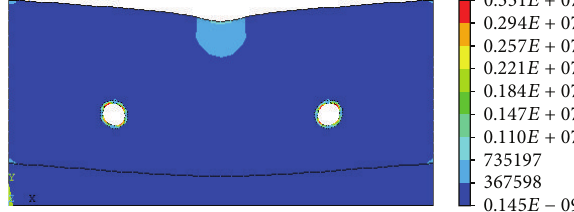
Figure 14: Stress distribution when load is applied at the middle.